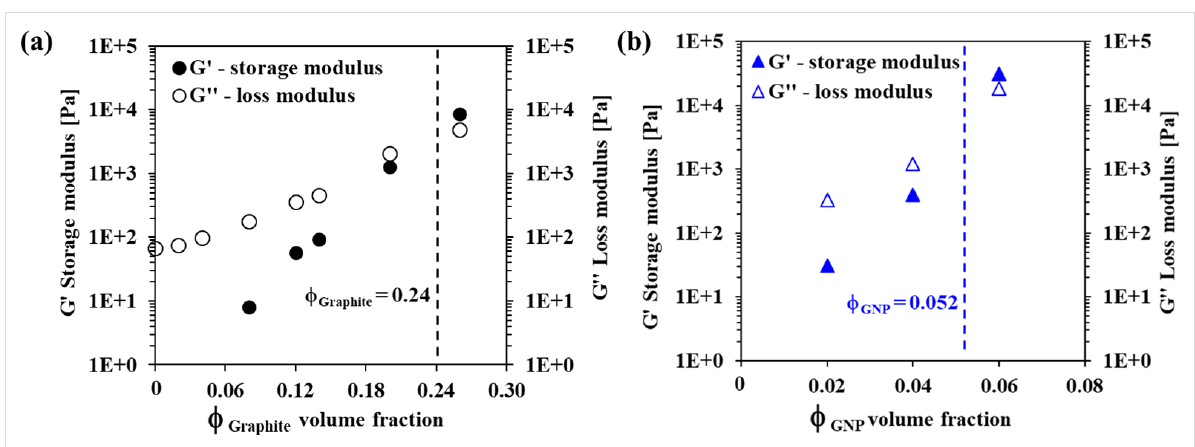
Figure 3: Storage modulus (G', solid symbols) and loss modulus (G', open symbols) as functions of the volume fraction of graphite (a) and GNP fillers (b) recorded at an oscillating frequency of 1 Hz and temperature of 25 °C. The dashed lines indicate the G'-G'' crossover volume fraction.